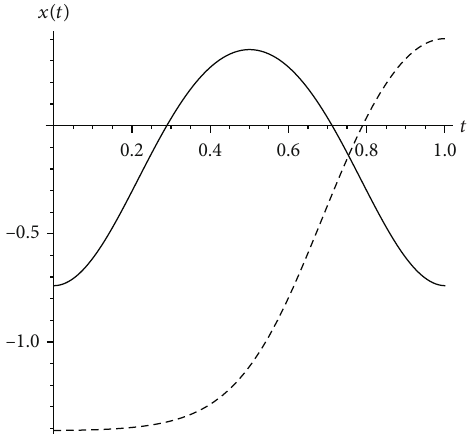
Figure 6: Graphs x ð t Þ for solutions of problems (15) and (30) x ≈ − 0 : 74 , x ≈ − 1 : 4092 (dashed). α